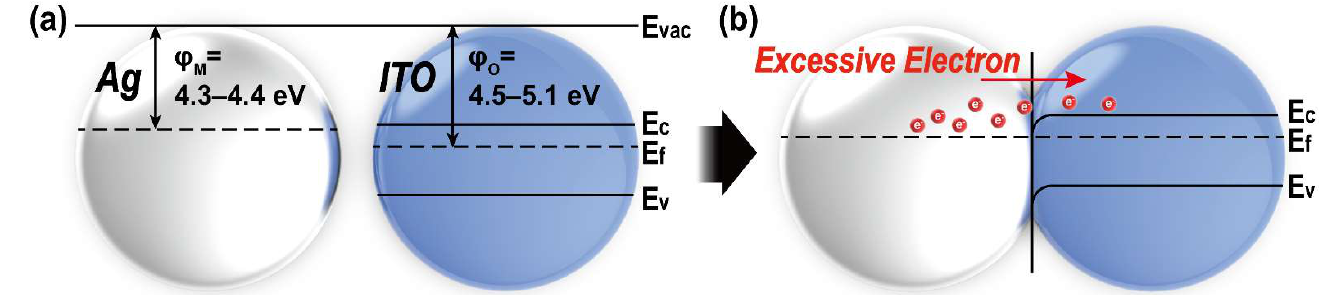
Figure 9. The energy band diagram for ITO and Ag ( a ) before and ( b ) after the junction formed. To quantitatively evaluate the performance of transparent conductive films with dif- ferent resistivity and transparency, the figure of merit (FOM, Φ (cid:3021)(cid:3004) ) was calculated using the equation proposed by Haacke